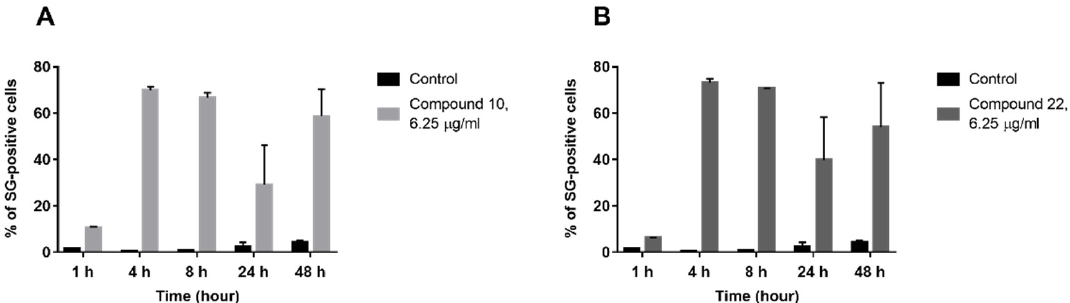
Figure 5. Compounds 10 and 22 caused increased membrane permeabilization on Lactobacillus plantarum . Both compounds caused membrane damage, which reflected in increased cellular fluorescence of SYTOX green (SG). The ratio of SG-positive cells was expressed in percent. ( A ) Membrane-permeabilizing effect of compound 10 ; ( B ) Membrane-permeabilizing effect of compound 22 .